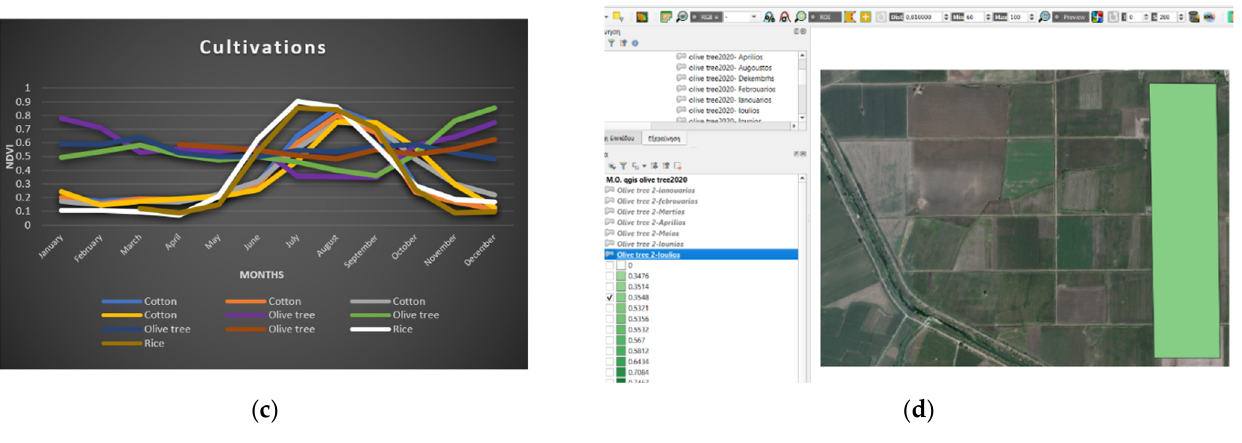
Figure 2. ( a ) Run of the training algorithm; ( b ) Graphical presentation of cotton crops’ NDVI dataset in month of July using color indicator; ( c ) Figure of training NDVI dataset; ( d ) Graphical presentation olive tree crop’s NDVI dataset on month July using color indicator.